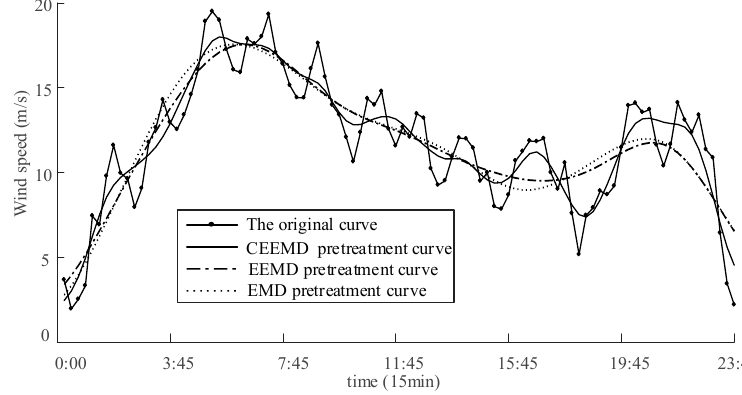
Figure 2. Wind speed curves reconstructed by different decomposition methods.